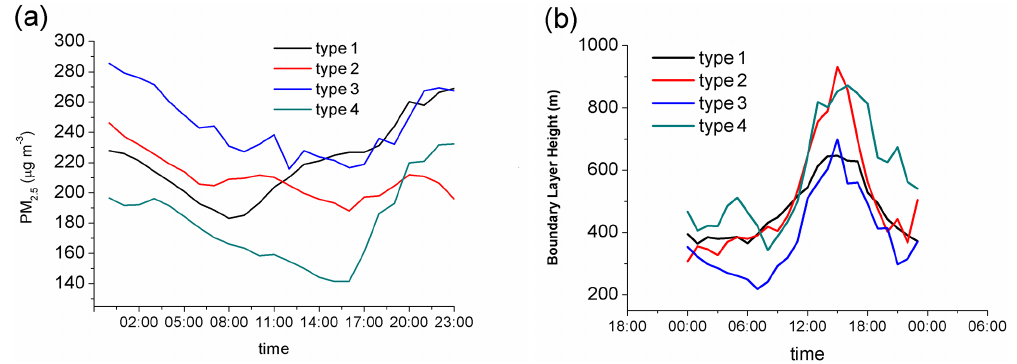
Figure 10. Diurnal variation characteristics of the (a) PM 2 . 5 averaged concentration (µgm − 3 ) and (b) boundary layer height (m) under the